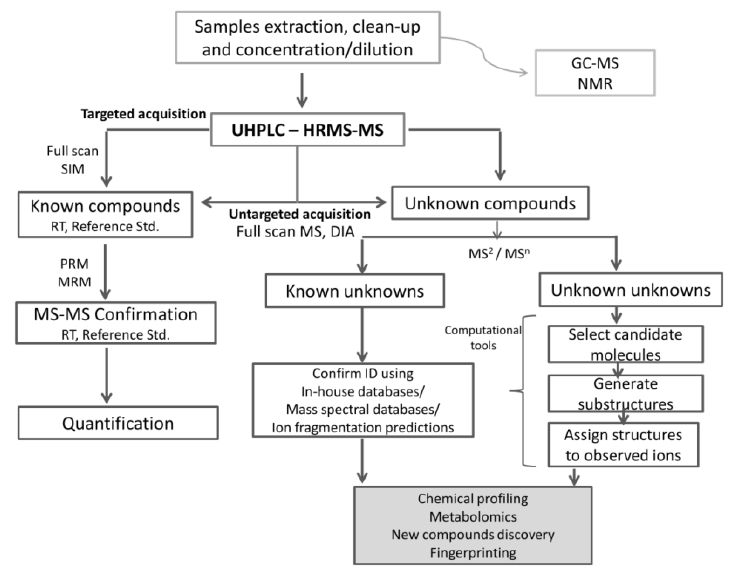
Figure 2. Workflow strategy in chemical profiling and metabolomics using HRMS technologies.